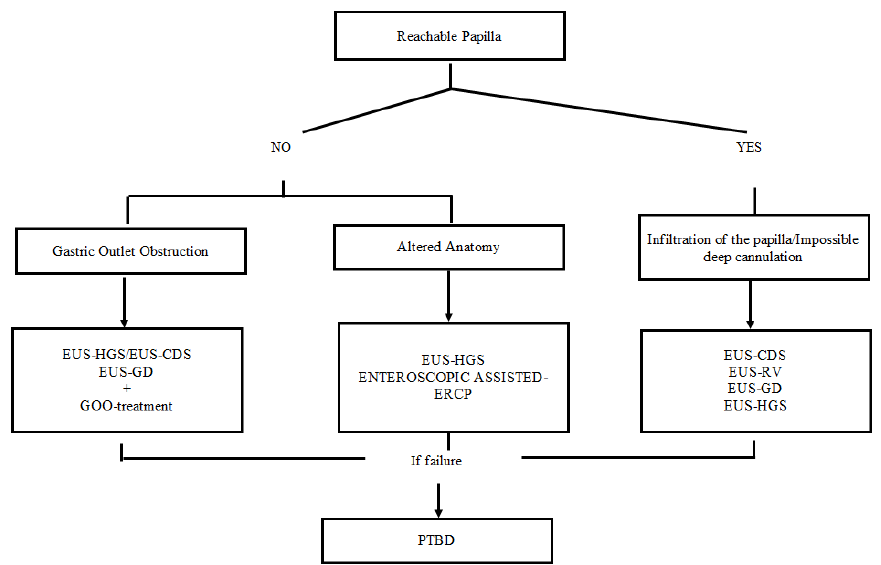
Figure 2. The proposed behavior in case of ERCP failure. EUS-GD may represent a possible rescue strategy in case of the failure of conventional EUS-guided approaches when cystic duct patency has been confirmed. Endoscopic Retrograde Cholangiopancreatography (ERCP); EUS-Guided Rendezvous (EUS-RV); EUS-Guided Choledochoduodenostomy (EUS-CDS); EUS-Guided Hepaticogastrostomy (EUS-HGS); EUS-Guided Gallbladder Drainage (EUS-GD), percutaneous transhepatic biliary drainage (PTBD).